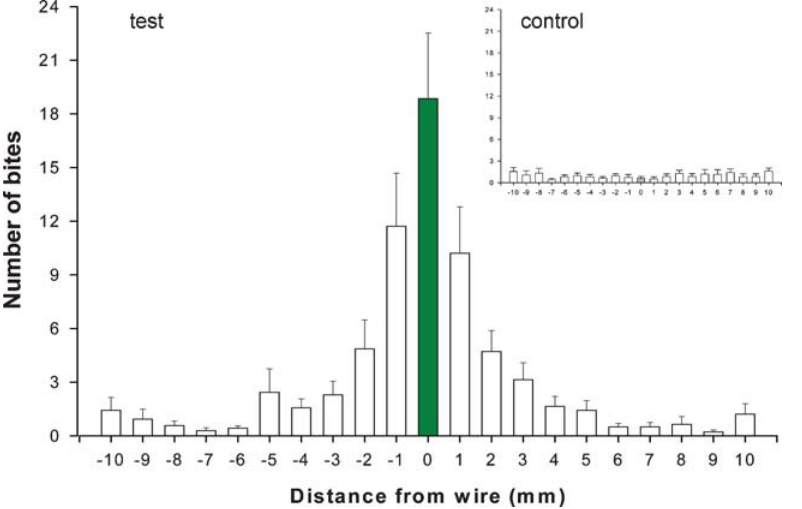
Figure 1. Mean distance of the sites of bites in relation to the position of the heated wire. Test: the wire was presented at 36 u C and the background at 33 u C. Control: both, the wire and the background were kept at 33 u C. Each bar represents the mean value plus the standard error of the number of bites perfomed over the wire (green bar) and at different distances from it by 14 insects along a period of 10 min after the first bite occurred.